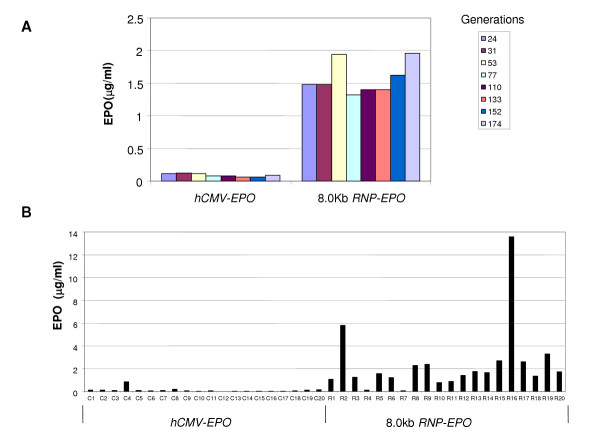
The 8.0 kb RNP fragment increases the yield of EPO in stably transfected CHO-K1 cells. A EPO production from pools of CHO-K1 cells stably transfected with hCMV-EPO or 8.0 kb RNP-EPO. Following selection on G418 pools of transfectants were cultured continuously with drug selection for 174 generations. Assays for EPO production were conducted every few days. B EPO production from clonal CHO-K1 cell lines derived with hCMV-EPO or 8.0 kb RNP-EPO. Clonal lines were derived by limiting dilution from pools of transfectants selected on G418. Colonies were expanded for 35 generations with drug selection prior to assay for EPO production.